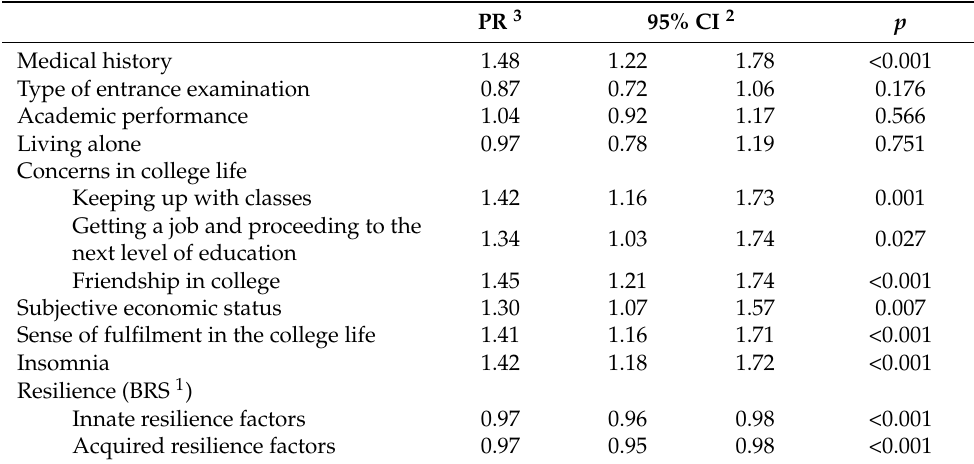
Table 3. Univariate Poisson regression analysis after multiple imputation ( n =